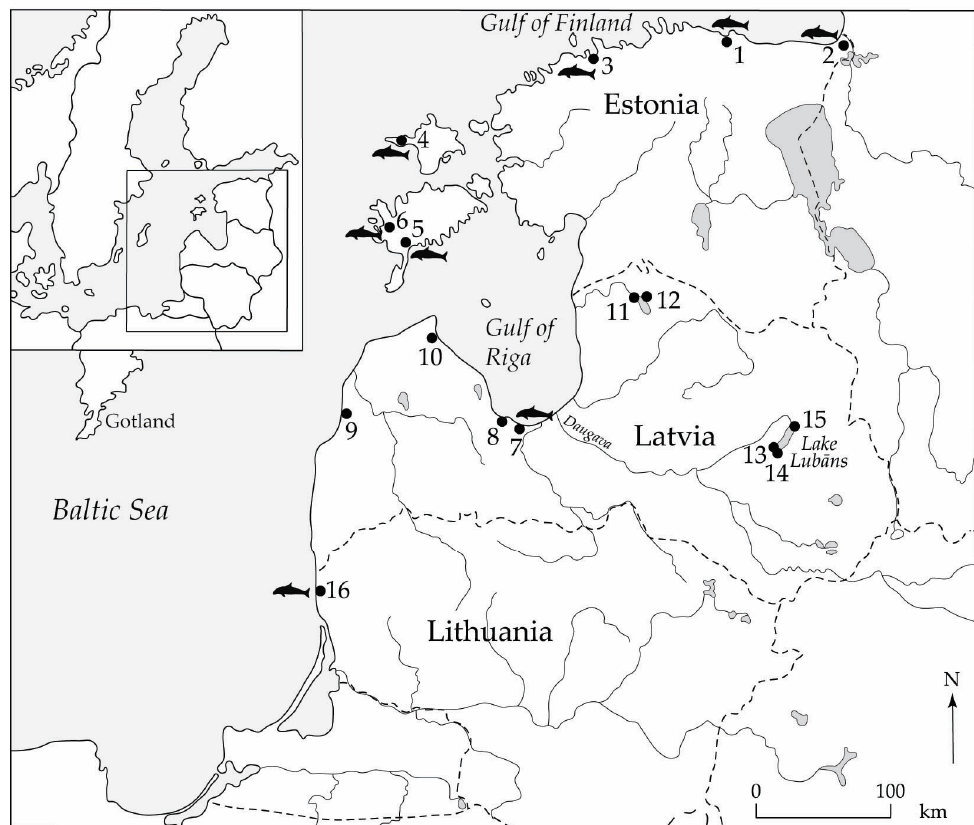
Figure 2. Neolithic sites with bone finds of porpoise (marked with porpoise symbol) and/or pottery with porpoise tooth impressions. 1—Kunda Lammasmägi; 2—Riigiküla; 3—Vabaduse Sq. in Tal- linn; 4—Kõpu; 5—Naakamäe; 6—Loona; 7—Sili ņ upe; 8—Slocene; 9—S ā rnate; 10—P ū rciems;